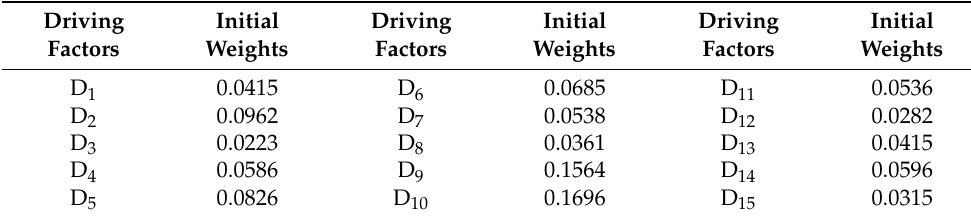
Table 6. Defuzzified values of the initial weights of the drivers.